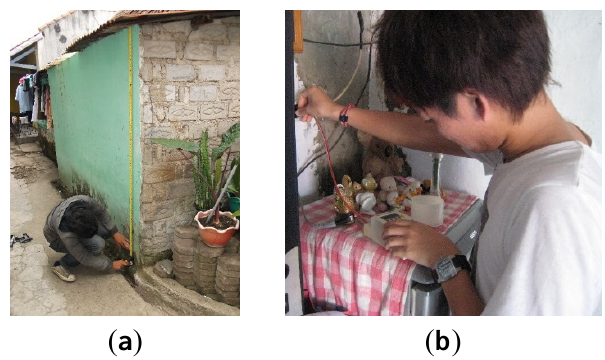
Figure 2. On-site measurements: ( a ) building material inventory; and ( b ) household energy